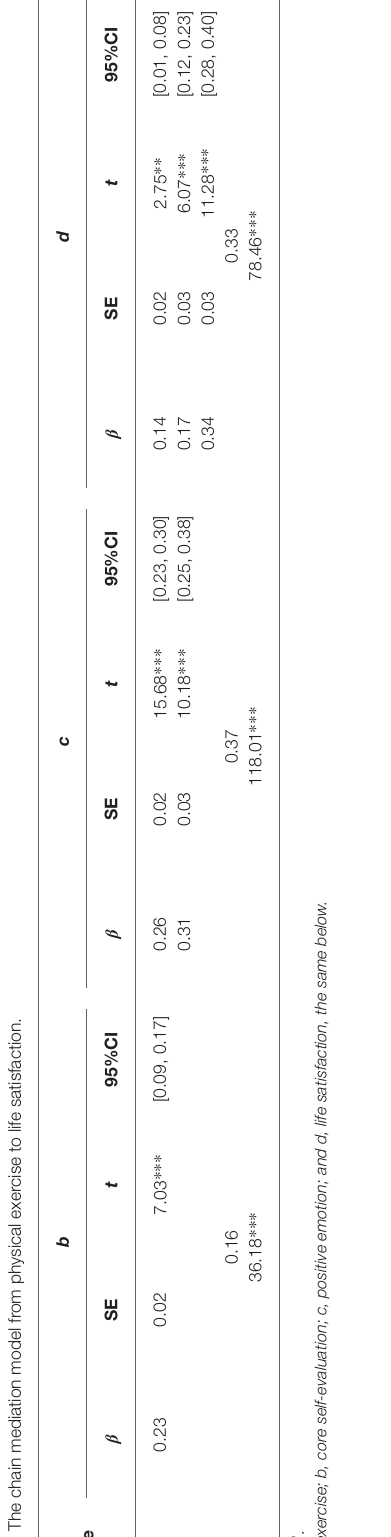
TABLE 3 | Standardized indirect effects from physical exercise to life